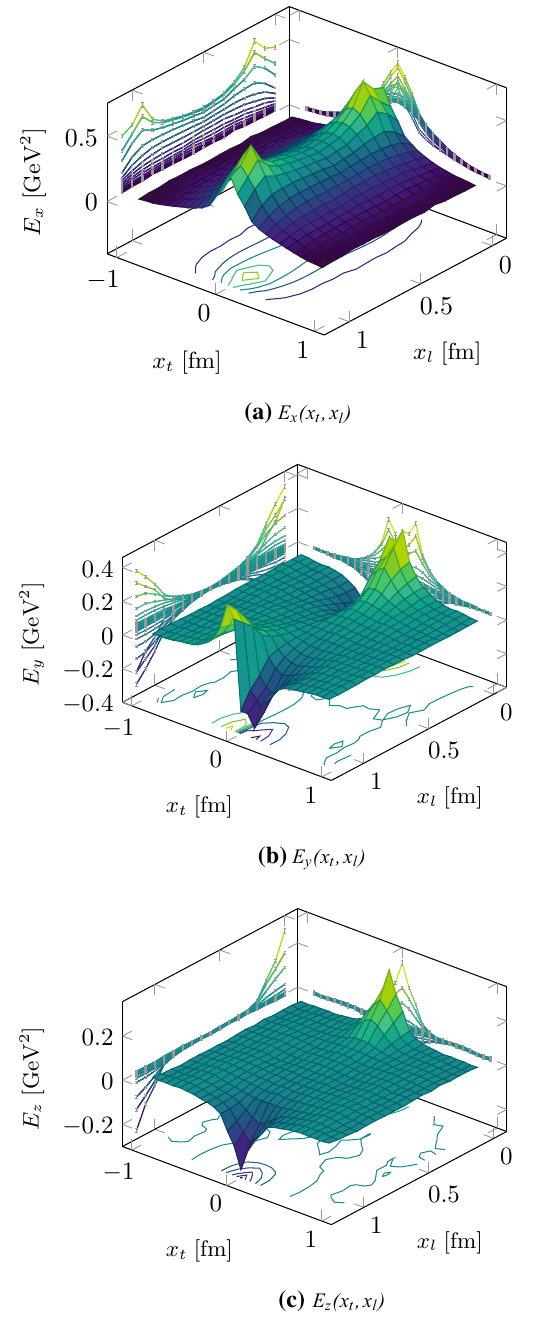
Fig. 2 Surface and contour plots for the three components of the chro- moelectric field at β = 6 . 240 and d = 1 . 142 fm. All plotted quantities are in physical units